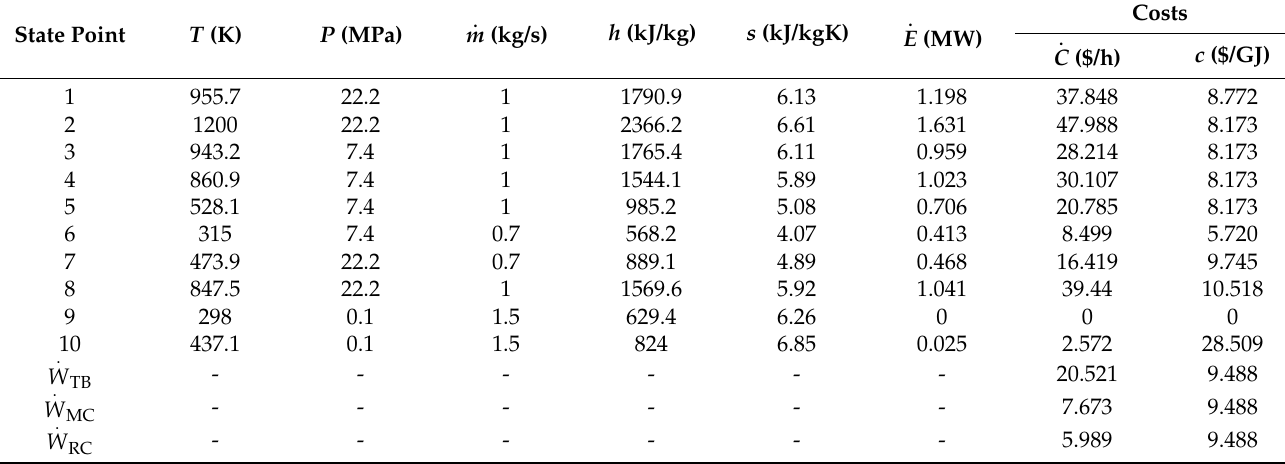
Table A5. Thermodynamic characteristics at different cycle state